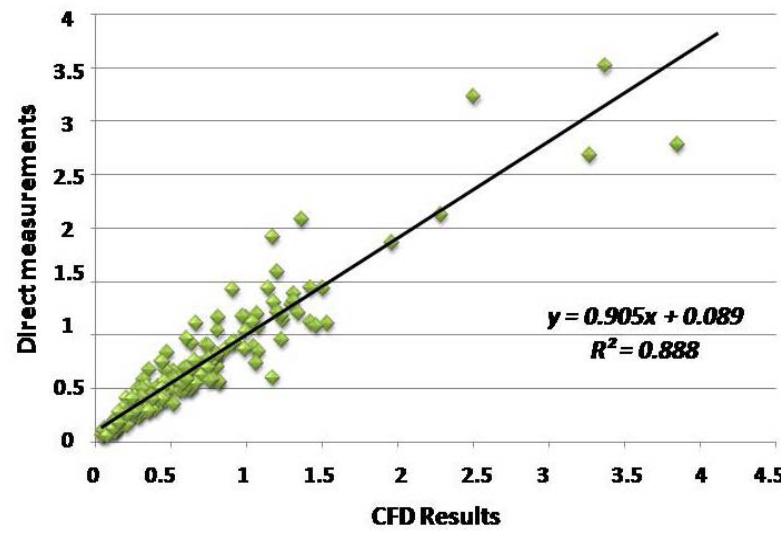
Figure 5. Regression curve of CFD results vs. direct measurements in the studied